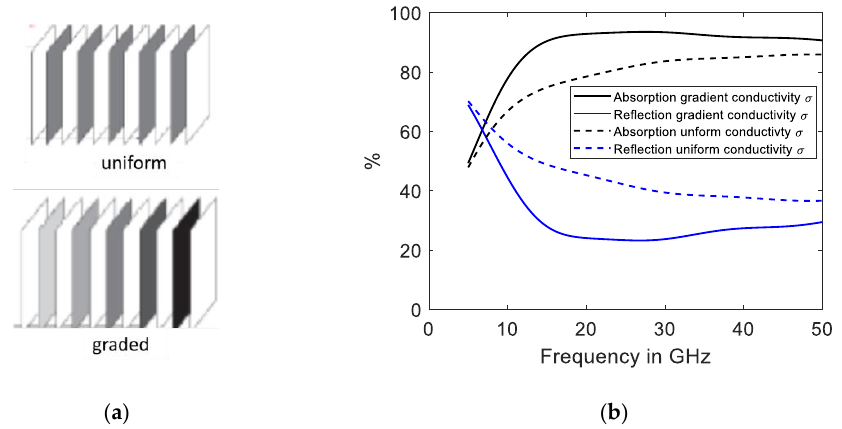
Figure 2. ( a ) Stacks alternating insulating and conductive PC sheets according to the method described in [15] ( b ) simulation demonstrating that stacking into gradient of conductivity improves absorption in a wide frequency range: five layers having conductivity linearly rising from 3 to 15 S/m are stacked between pure polymer layers. The dashed curves correspond to uniform concentration from layer to layer.